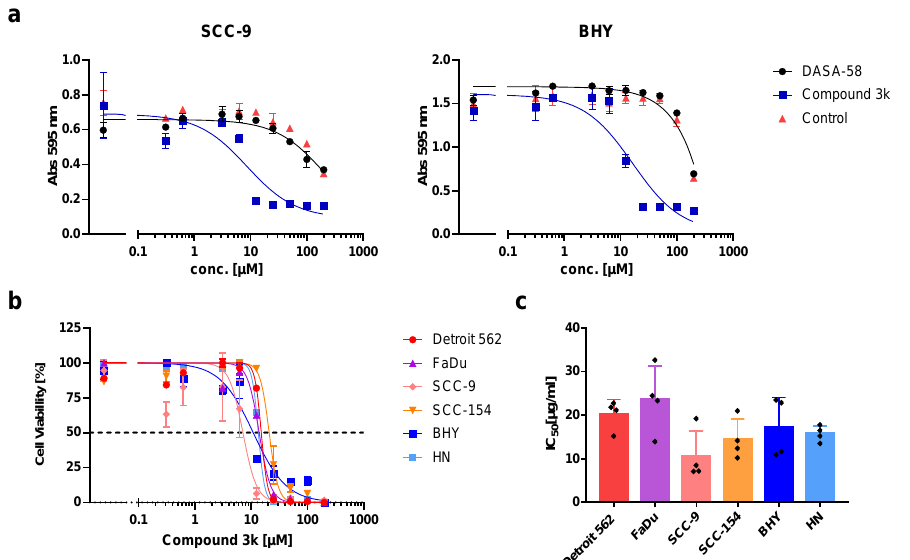
Figure 3. Cytotoxic activity of DASA-58 and Compound 3k on HNSCC cell lines. ( a ) Viability of cell lines SCC-9 and BHY treated with different concentrations of indicated compound or DMSO (control) for 48 h. Cells were stained with crystal violet, and absorption at 595 nm was measured. First data points on the left correspond to cells treated with medium alone. ( b ) Normalized cell viability after treatment with different concentrations of Compound 3k for 48 h. Data were fitted using non-linear regression. Dotted line indicates 50% cell viability. ( c ) IC 50 values (inhibitor concentration at 50% viability) for Compound 3k derived from data as shown in ( b ). Mean values and SD of four independent experiments are depicted.